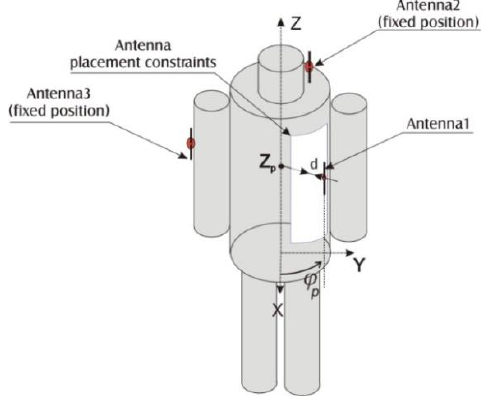
Figure 5. Six-cylinder model and feasible region (chest node region).